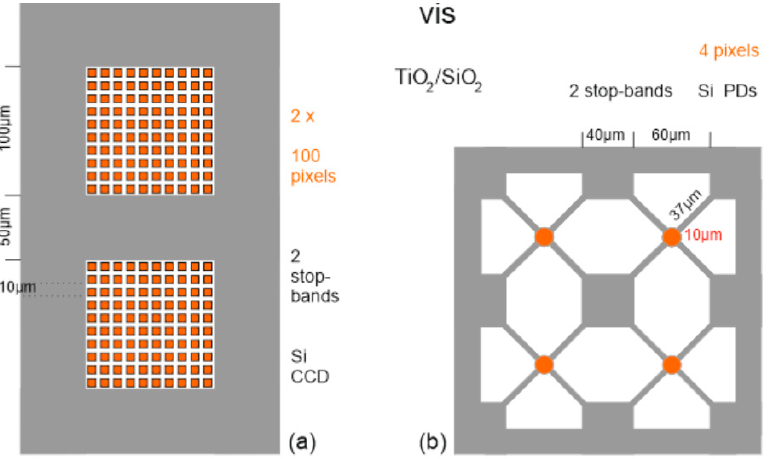
Figure 25. Space requirement to cover 400 nm in the VIS spectral range using two neighboring TiO 2 /SiO 2 stopbands for the DBRs and PDs/CCDs in the Si material system. ( a ) Static FP filter array. ( b ) MEMS tunable FP filters.